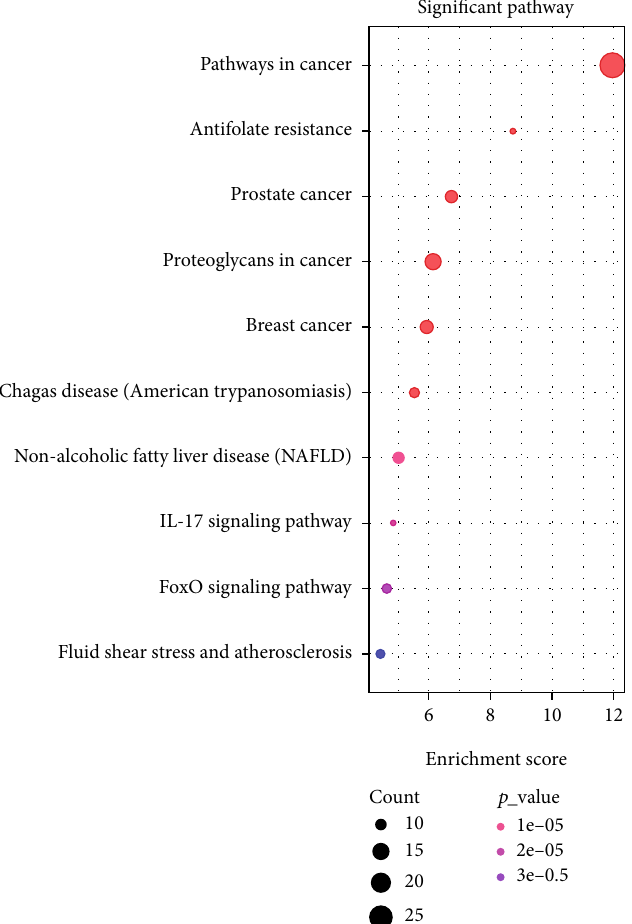
Figure 7: KEGG enrichment analysis of genes in the network of “ Chinese medicine compound-components-targets ” : bubble